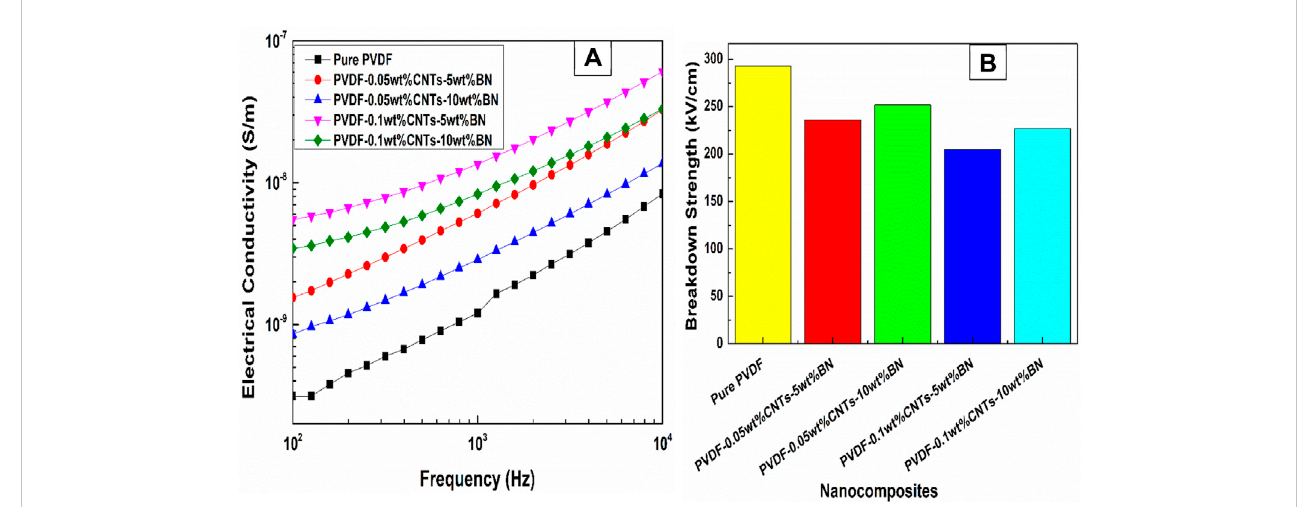
FIGURE 7 (A) Electrical conductivity and (B) breakdown strength of the